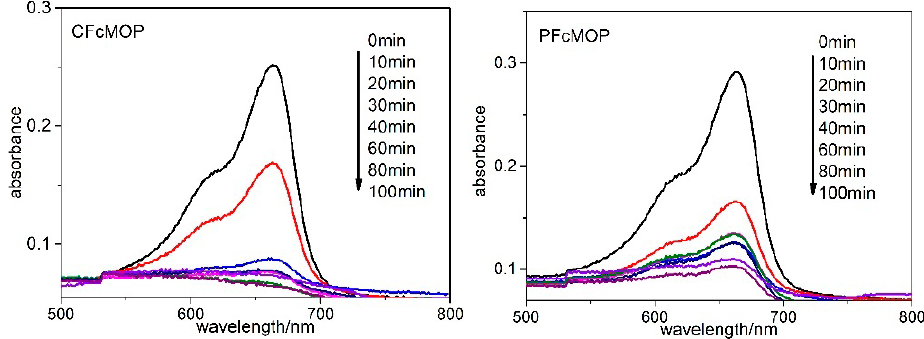
Figure 4. UV absorption spectrum of MB solution.